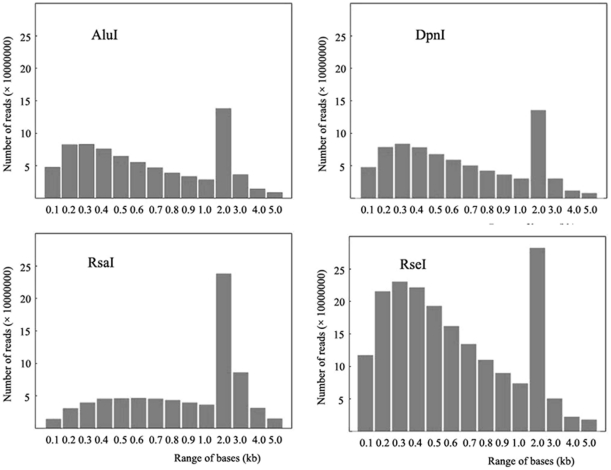
Frequency distribution of the rapeseed genome sequences.Here we show the rapeseed genome sequence after digestion with fourblunt end enzymes, AluI, DpnI, RsaI and RseI, respectively (computer simulated).